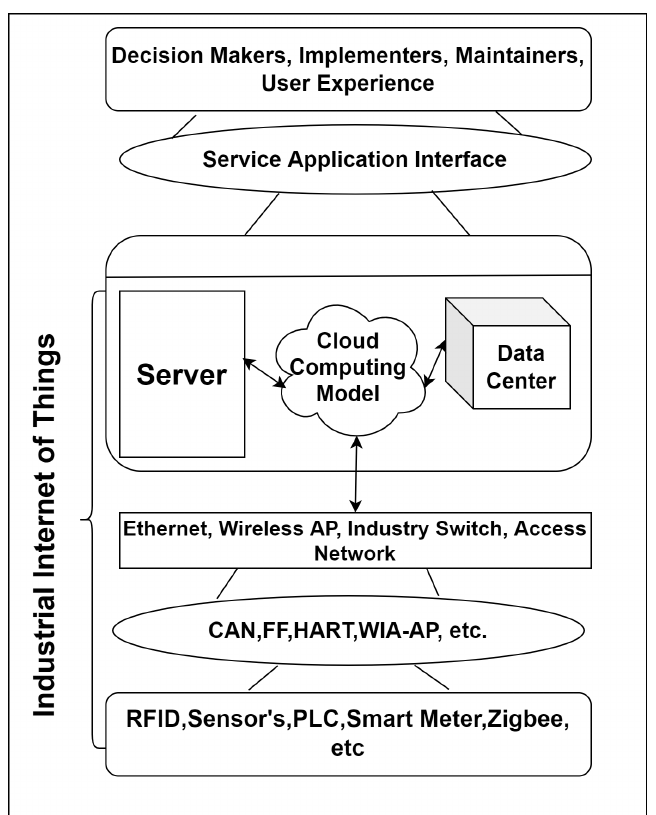
Figure 1. Cloud-based architecture of